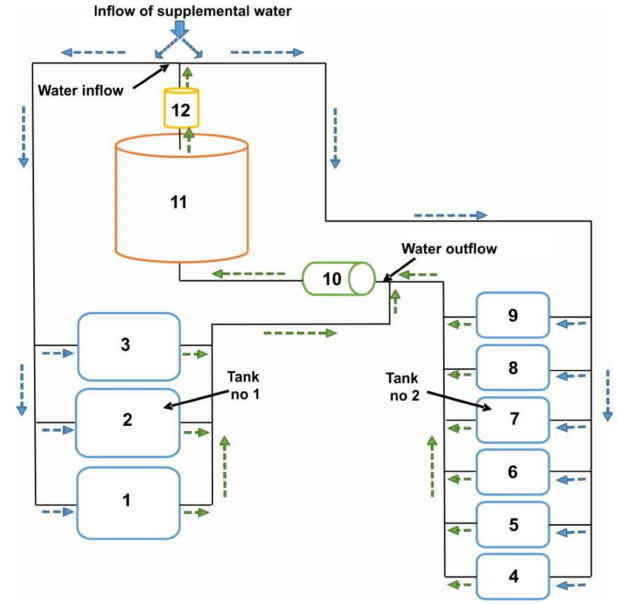
Figure 1. Diagram of the recirculating aquaculture system (RAS) and water sampling sites. Denotations: 1, 2, 3—fish rearing tanks (0.98 m 3 ); 4, 5, 6, 7, 8, 9—fish rearing tanks (0.32 m 3 ); 10—microstrainer; 11—trickling filter; 12—UV